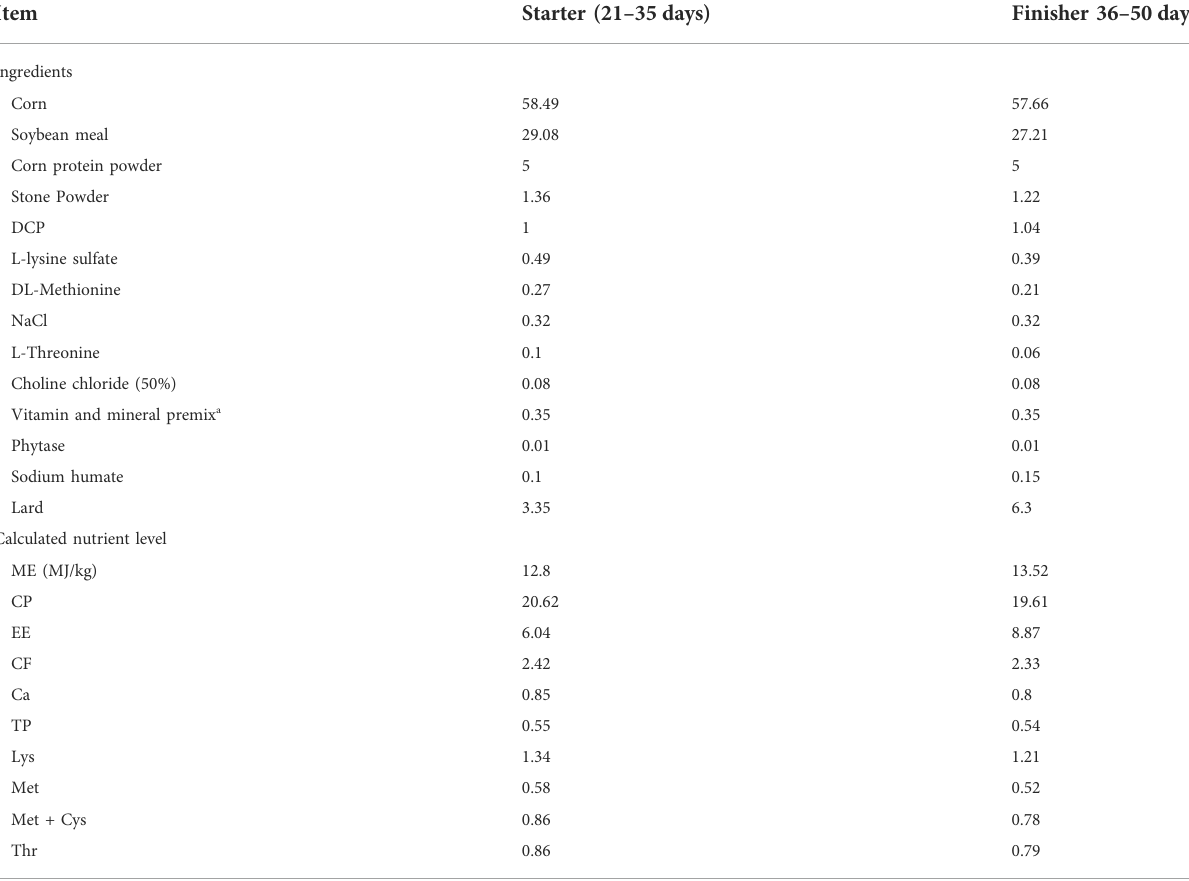
TABLE 1 Composition and nutrient level of the basic diet (as feeding basis).